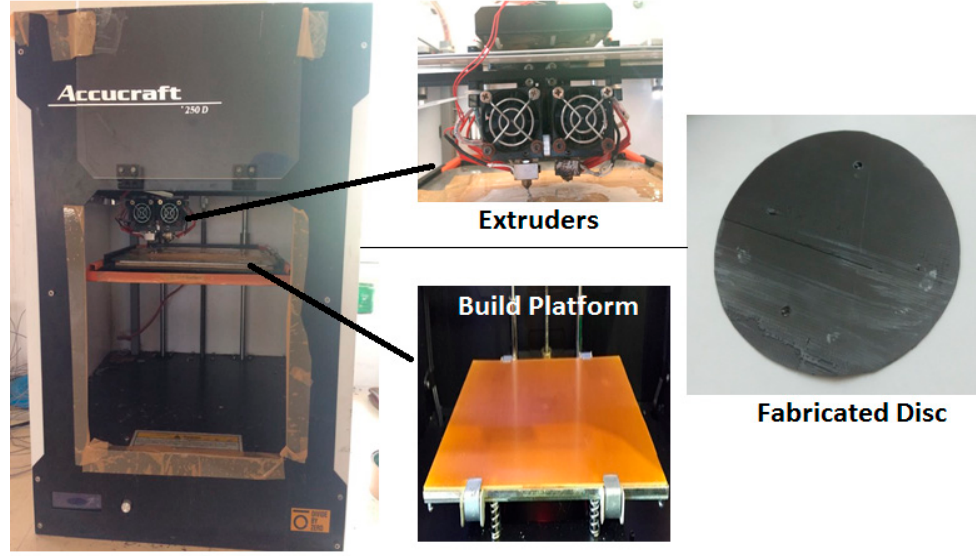
Figure 5. Preparation of functional prototype on FDM.